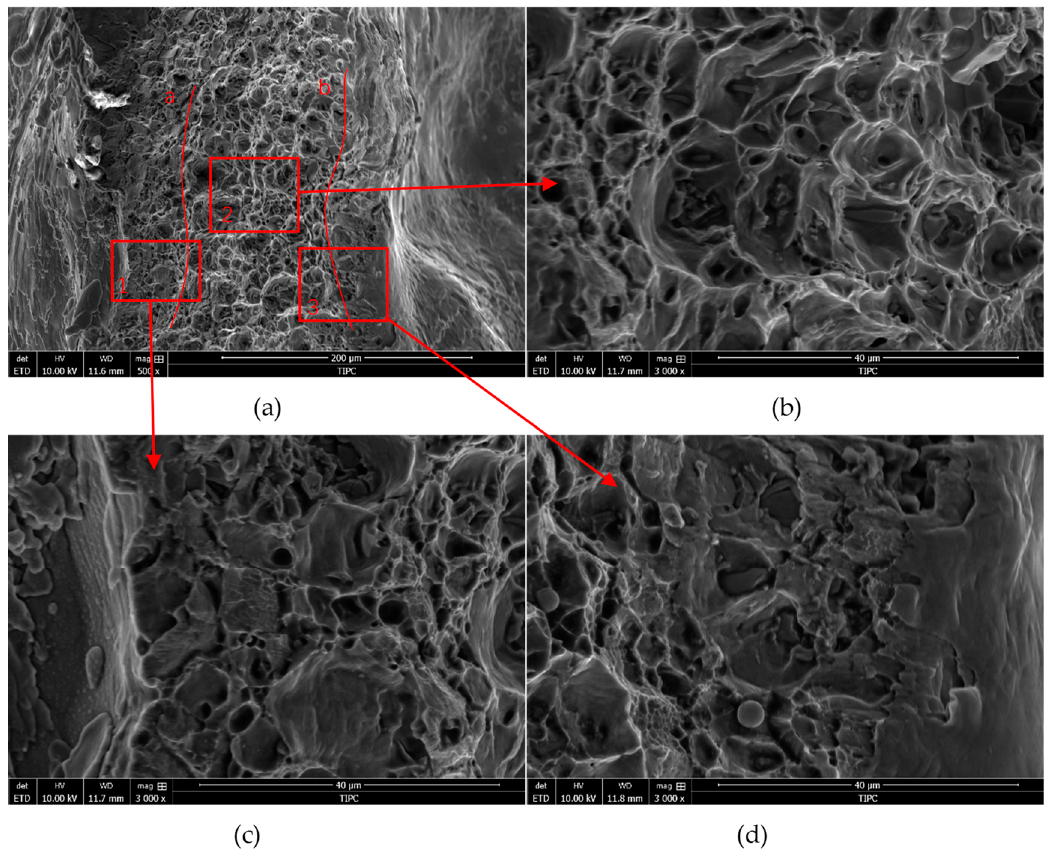
Figure 6. SEM images of nanosecond laser ablation of aluminum alloy fractures. ( a ) is the 500× magnified image of the fracture, ( b ) is the 3000× magnified image of zone 2, ( c ) is the 3000× magnified image of zone 1, and ( d ) is the 3000× magnified image of zone 3. The lines corresponding to letters a and b are the demarcation lines between the two morphologies.